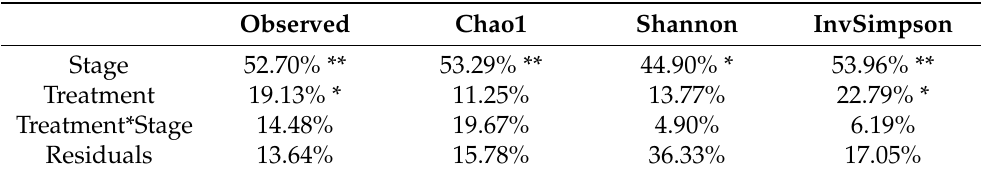
Table 2. Percentage of variance explained by treatment and stage factors for different biodiversity indices (significance codes for p value: ** 0.01 and *